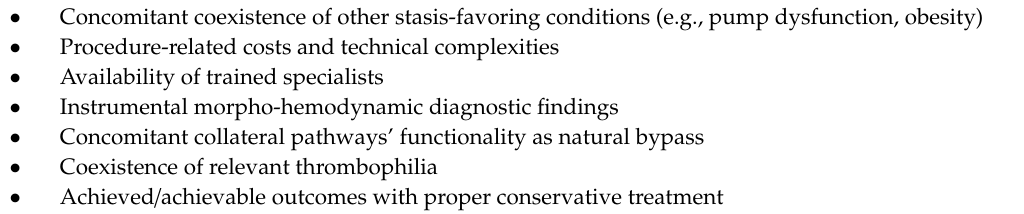
Table 5. Decisional factors in endovascular / surgical intervention for post-thrombotic